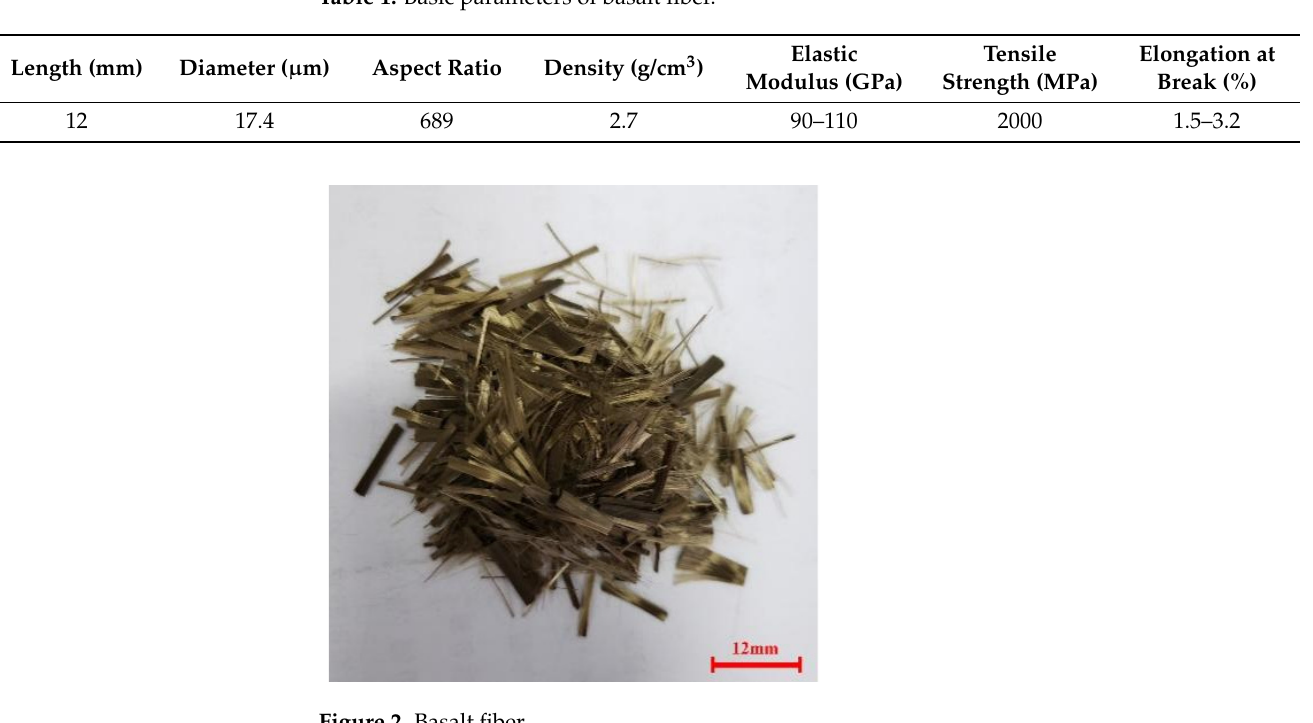
Figure 2. Basalt Figure 2. Basalt fiber. Table 1. Basic parameters of basalt fiber.